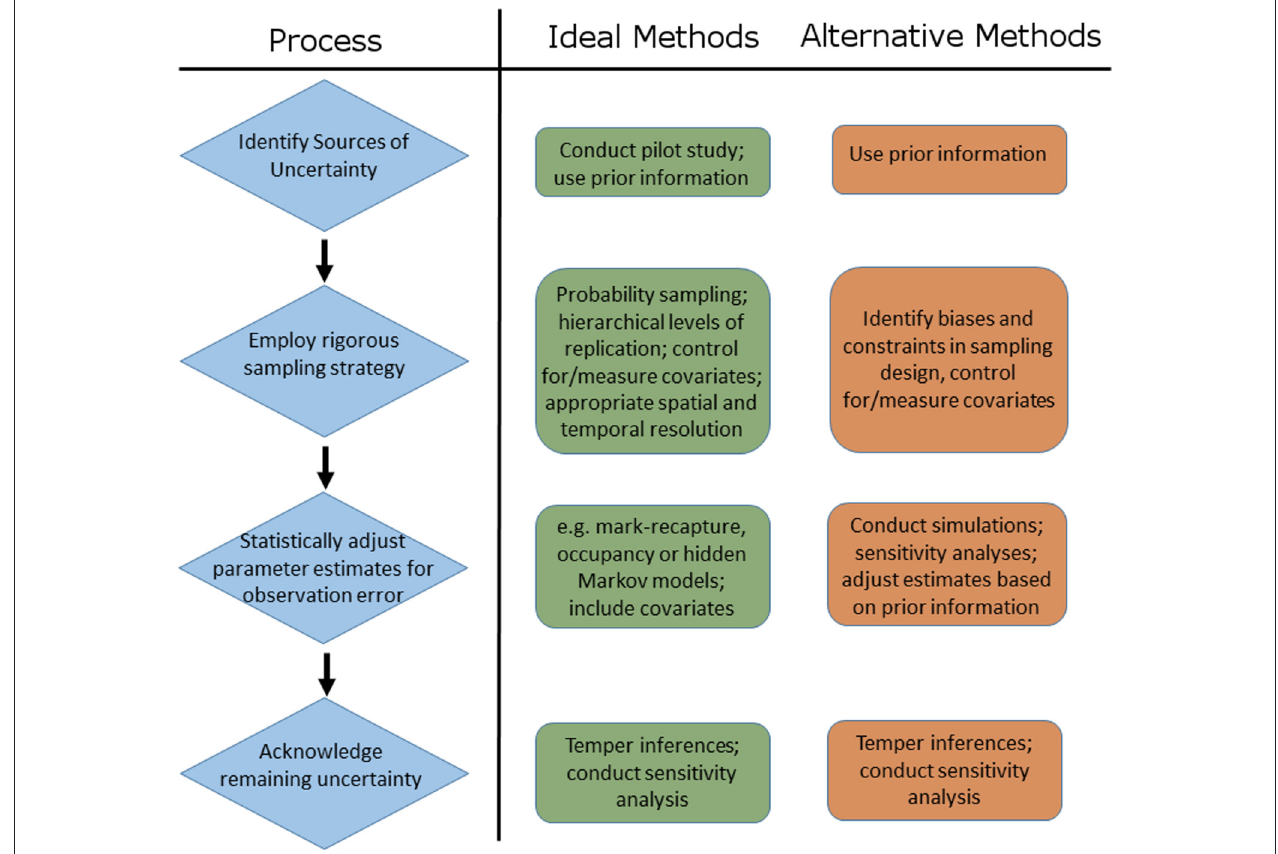
figURe 8 | Schematic representation of the process of accounting for sources of uncertainty in disease ecology studies, including examples of ideal and alternative methods that can be used to address each step of the